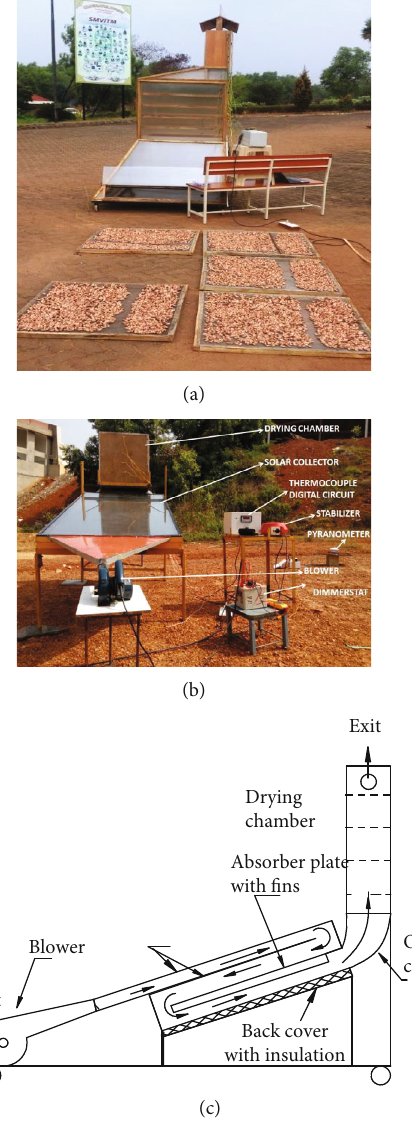
Figure 1: (a) Natural convection solar greenhouse dryer. (b) Forced convection FPC solar dryer. (c) Schematic